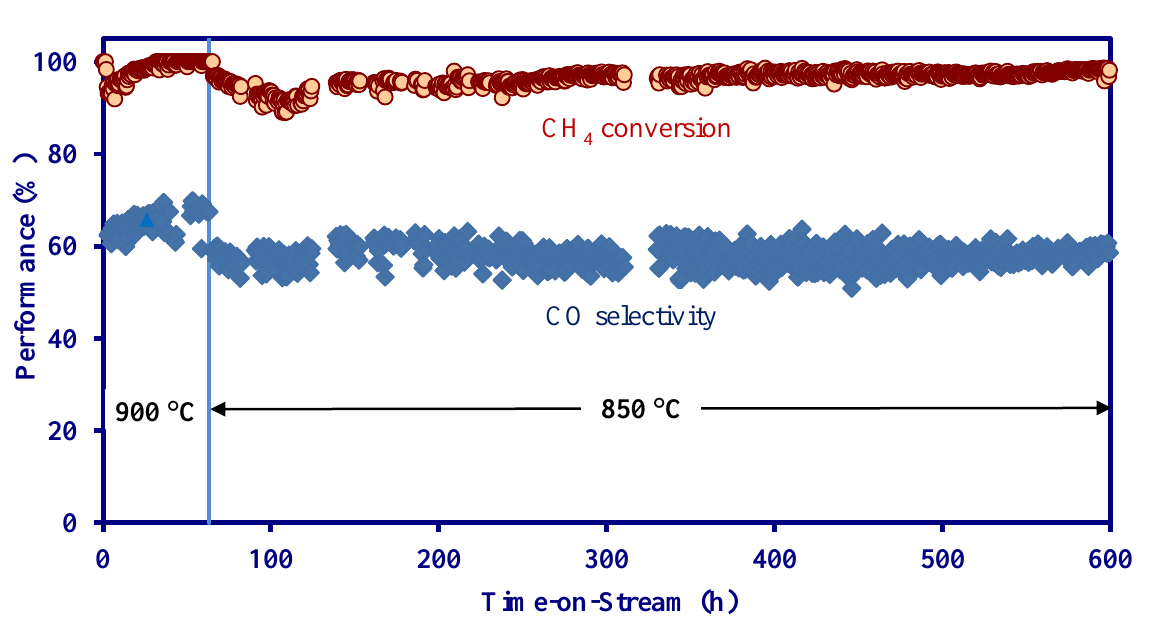
Figure 6. Reforming of biomass gasification products on a MNS-washcoated on catalyst-extruded monolith under the conditions of 3.7% H